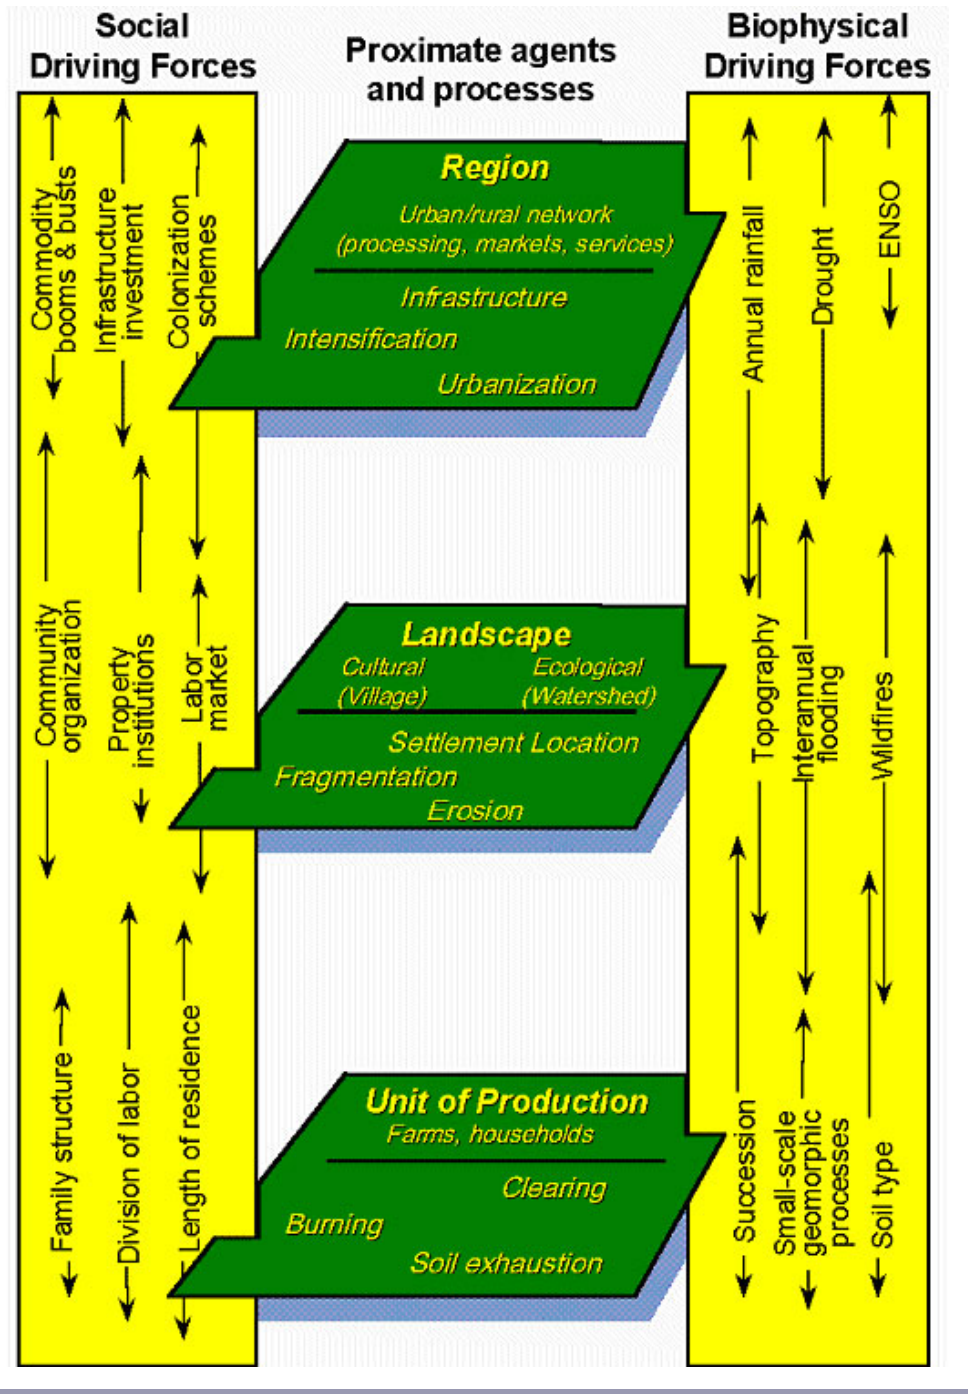
Fig. 2 . Multiple scales of driving forces and proximate agents of change (adopted from Folke et al., 1998 a